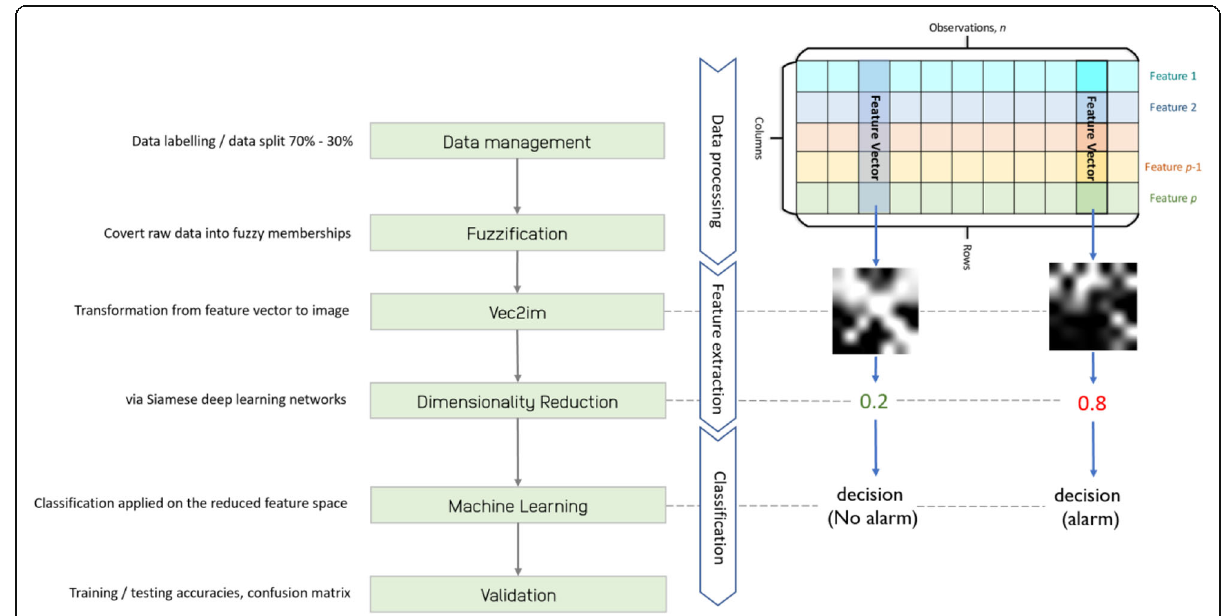
Fig. 1 The proposed Vec2im-Siam